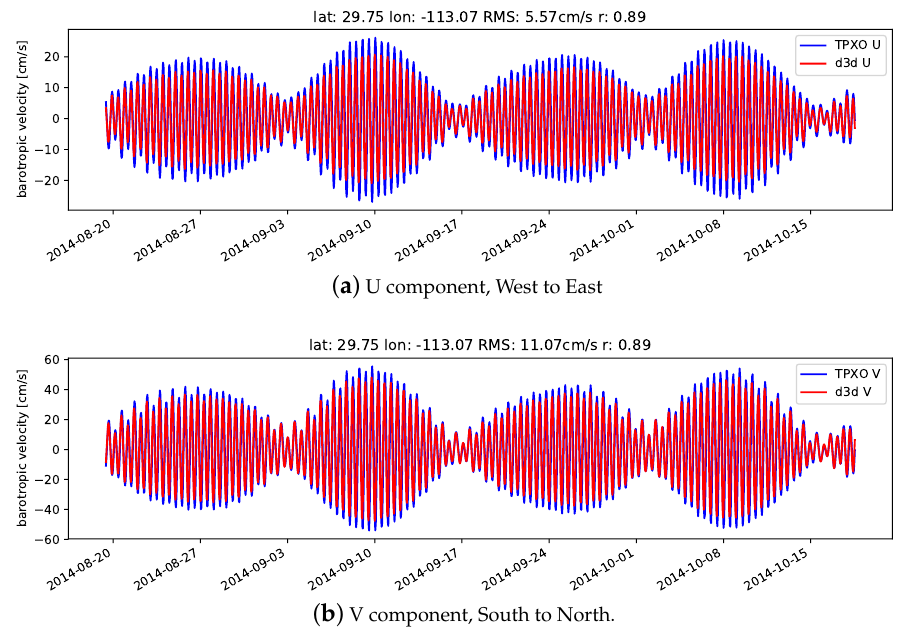
Figure 7. Time-series of components of the barotropic current at latitude 29.75 N, longitude—113.07 E. The delf3D (d3d) components have been depth-averaged for comparison. All dates in